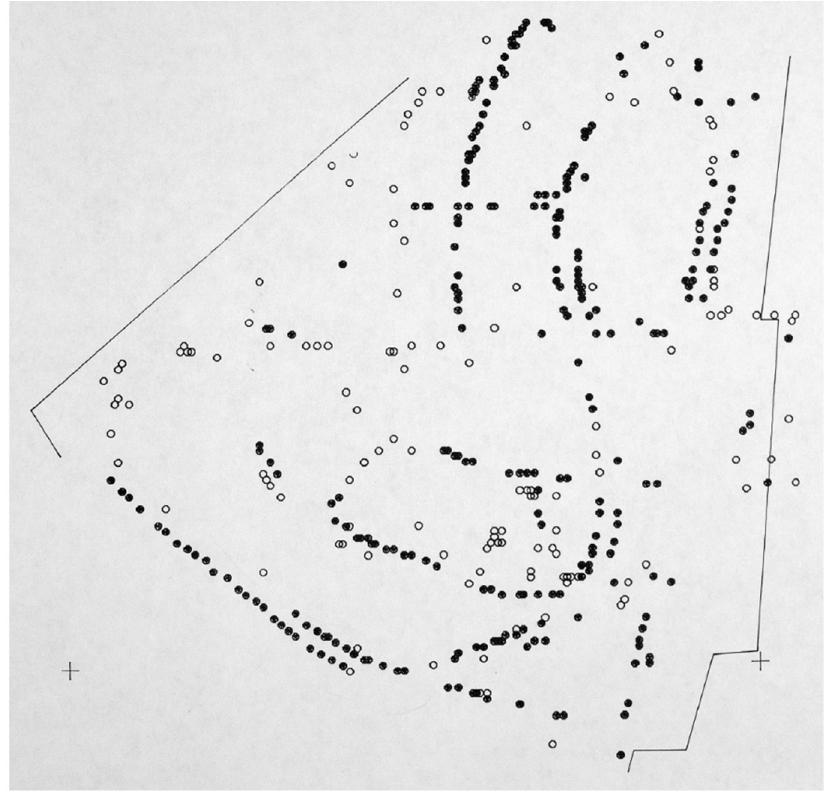
Figure 5. Disfigured Trees, map by Shaub Dunkley ([5], p. 51, used with